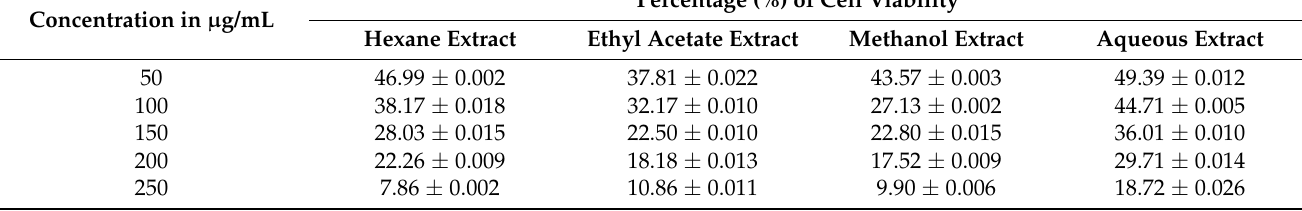
Table 2. Anticancer activity of different solvent extracts of C. colocynthis against the lung cancer A549 cell line.